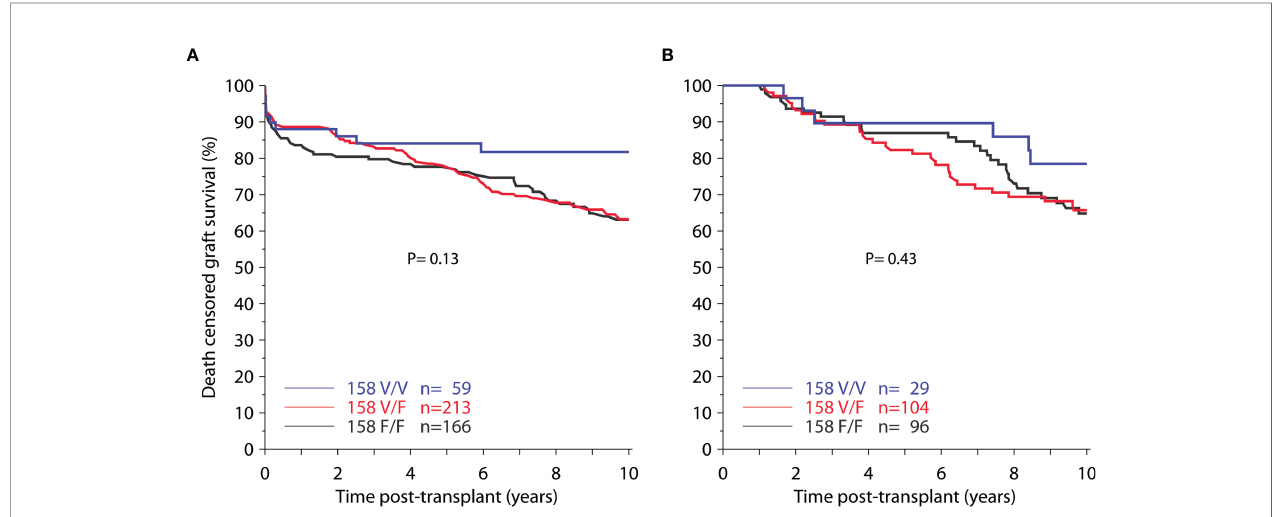
FIGURE 3 | Death-censored graft survival among (A) 438 pre-sensitized recipients (panel reactivity > 0%) and (B) 229 recipients with treated rejection during the fi rst-post-transplant year, in relation to FCGR3A -V/F158 genotype.